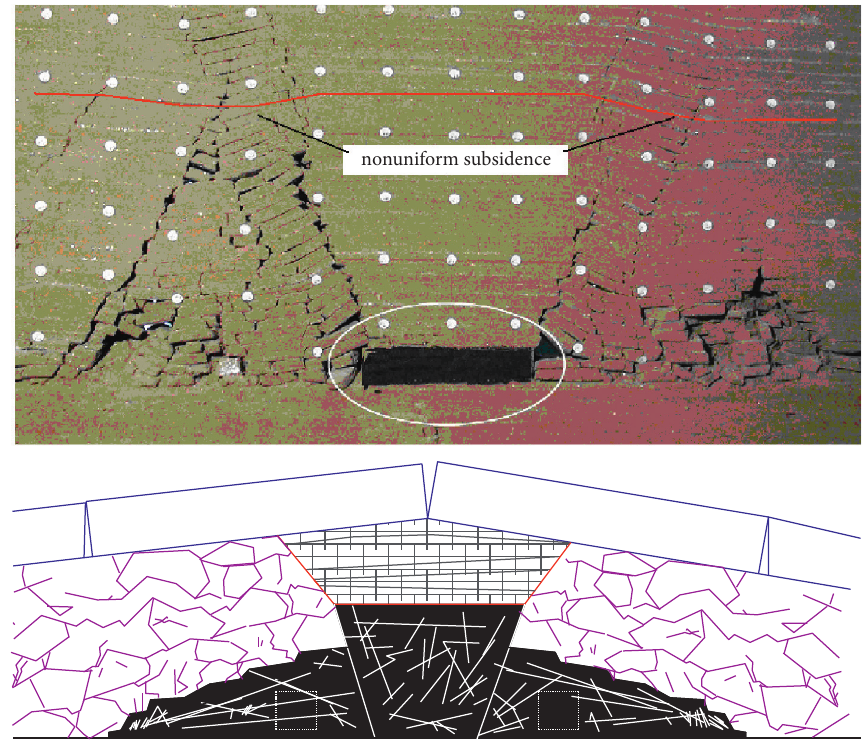
Figure 3: Nonuniform deformation above a chain/gate